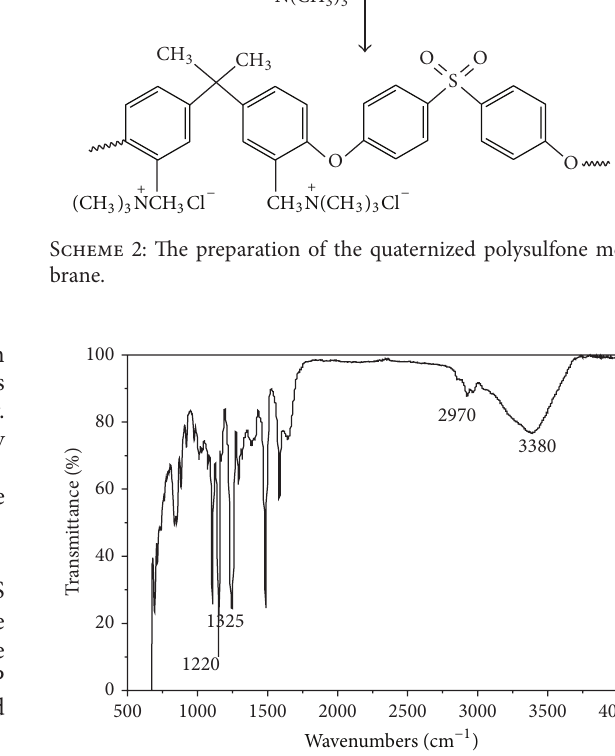
Figure 1: FT-IR spectra of quaternized polysulfone